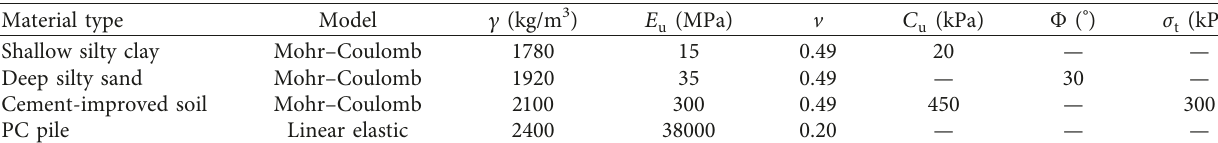
Figure 3: 3D finite element models of (a) entire pile-soil system and (b) pile with improved soil surround. Table 2: Material models and parameters used in this